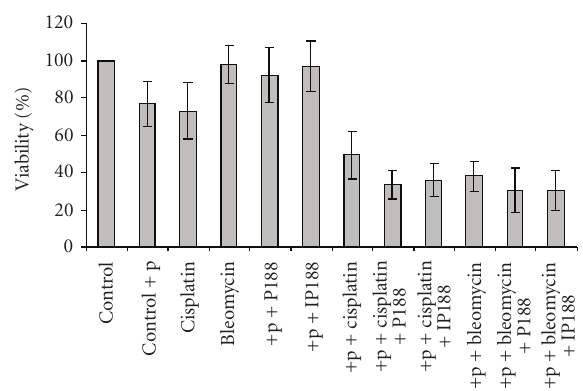
Figure 1: MTT test of treated MDA-MB-231 cells at 24 hoursours after treatment; 5 · 10 5 cells suspended in 100 μ l of a bu ff er (0.3M mannitol, 0.1 mM Ca acetate and 0.1mM Mg acetate) were electroporated according to the following electrical parameters: field strength 1.0kV · cm − 1 and one rectangular pulse with a duration of 5 ms. Cisplatin was used at 10 μ M and bleomycin—at 20 μ M concentration. +p indicates electroporated probes, +P188 indicates that cells were electroporated in the presence of 0.1 mM P188, and + | P188 (0.1mM) indicates the addition of P188 after the electrical pulse. All probes were diluted under identical conditions. The data represent the mean values from three